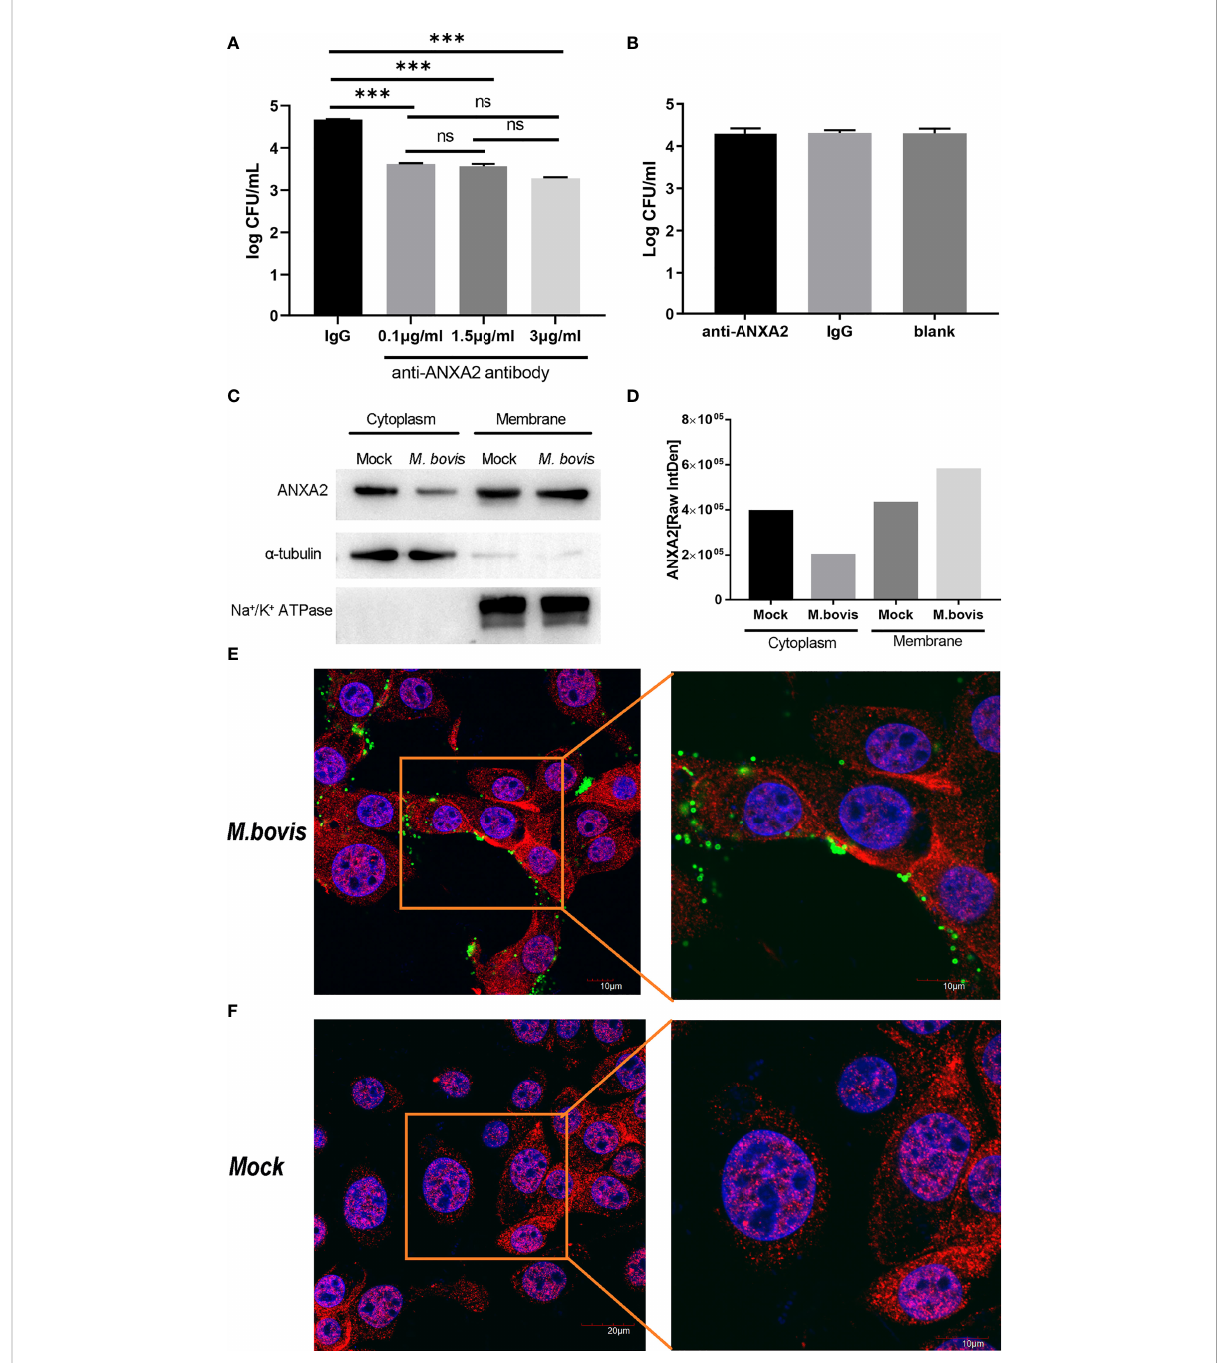
FIGURE 2 M. bovis infection promotes the recruitment of ANXA2 from cytoplasm to membrane surface of EBL cells which in turn is necessary for M. bovis adhesion. (A) M. bovis adhered with EBL cells was reduced by an anti-ANXA2 monoclonal antibody (mAb) in a dose-dependent manner. Data represent means ± SD. ns means no signi fi cant, *** p < 0.001. (B) Cells treated with an anti-ANXA2 mAb before M. bovis infection did not affect M. bovis invasion. (C) . The levels of ANXA2 in the cytoplasmic and membrane fractions of mock- and M. bovis - infected EBL cells at 12 hpi using a -tubulin as a cytoplasmic protein marker and Na + /K + ATPase as a membrane protein marker. (D) ImageJ was used to analyze the band grey intensity of the western blot assay (C) , which was expressed as the raw integrated density (Raw IntDen). (E , F) Observation of ANXA2 location using confocal microscopy. Live M. bovis was infected into EBL cells respectively and set a noninfected group as negative control. After 12 hpi, ANXA2 was detected using rabbit polyclonal anti-ANXA2 and secondary goat anti-rabbit IgG conjugated with Alexa Fluor 555 (red), and M. bovis was detected using anti- M. bovis monoclonal antibody 1C11 as the primary antibody, followed by a secondary goat anti-mouse IgG antibody conjugated with Alexa Fluor 488 (green), the nuclei were counterstained with DAPI